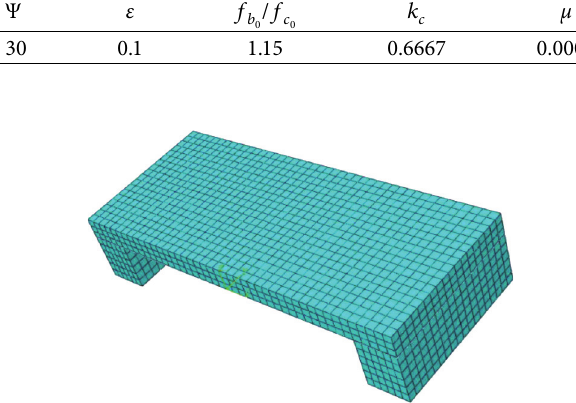
Figure 24: Meshed composite slab